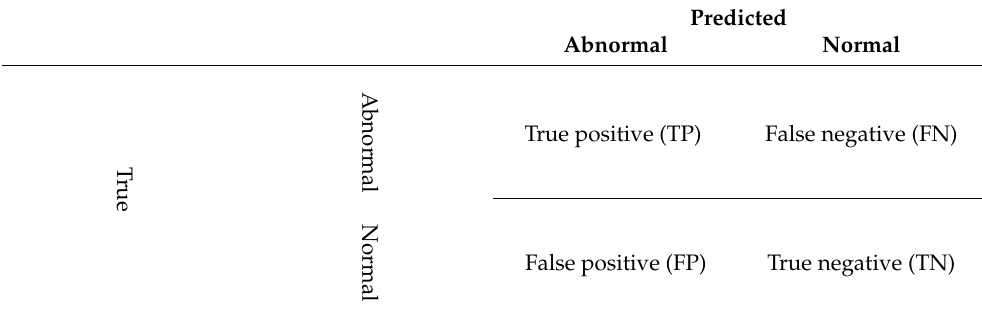
Table 3. Confusion